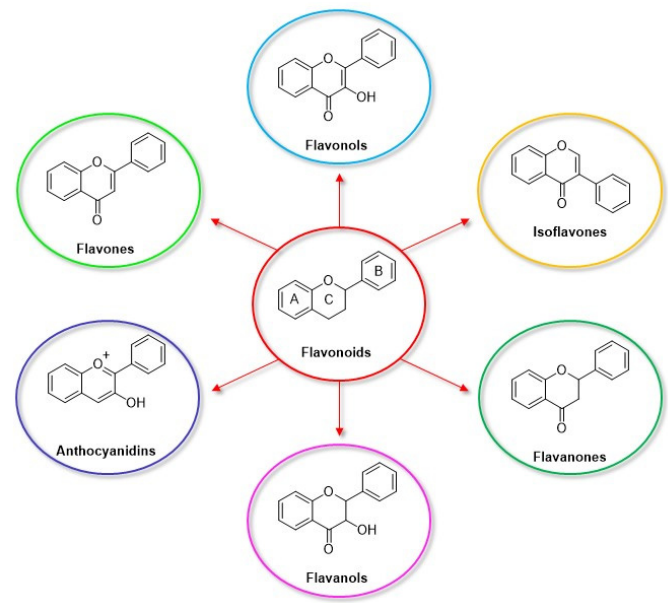
Figure 12. Structures of flavonoids and their subgroup classification.